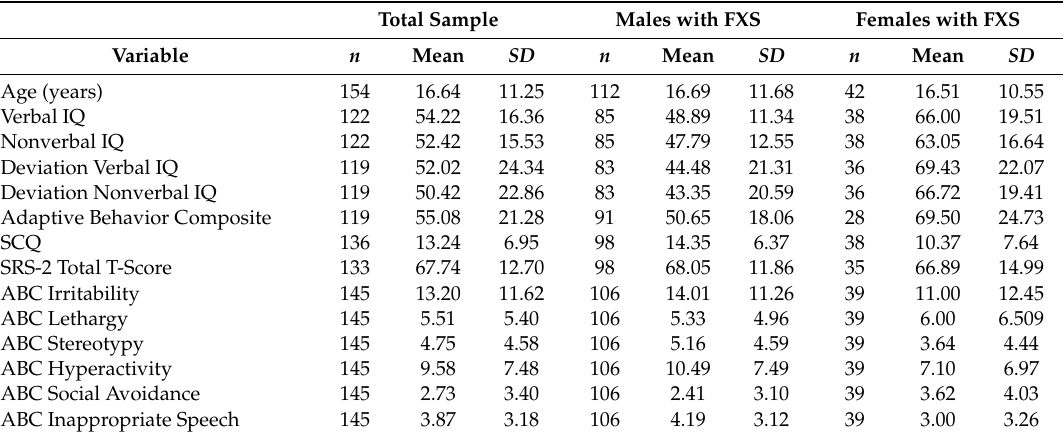
Table 1. Participant